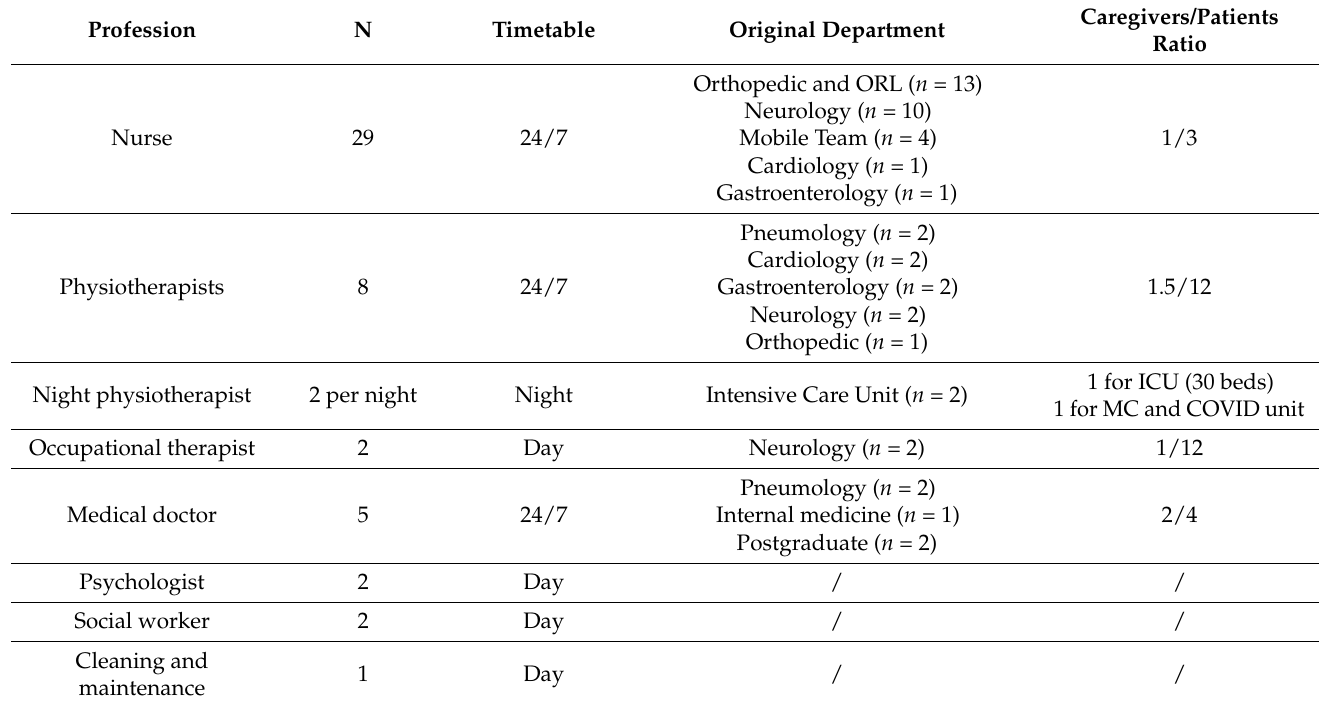
Table 2. Composition and organization of the Middle Care